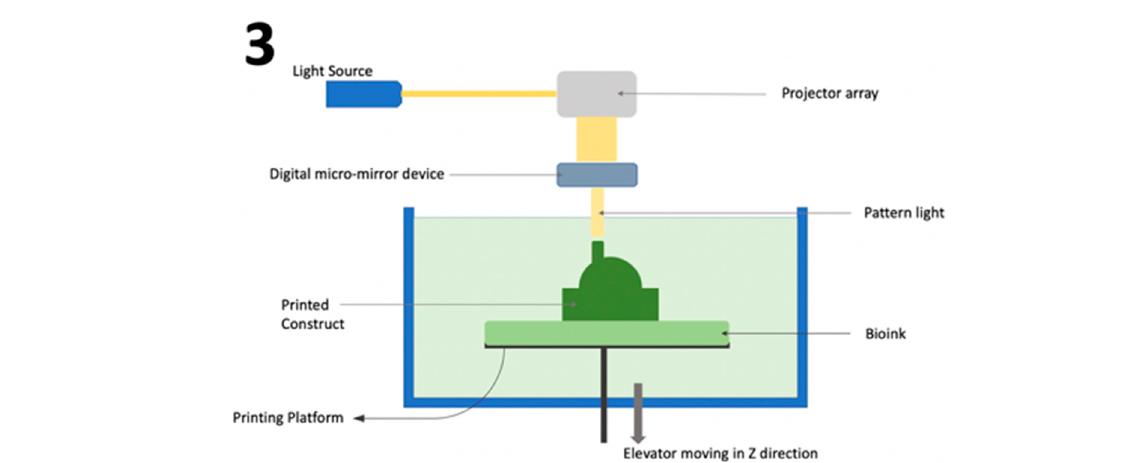
Figure 3. Schematic illustrations of (1) extrusion-based bioprinting, (2) inkjet bioprinting (2), and (3) stereolithography.